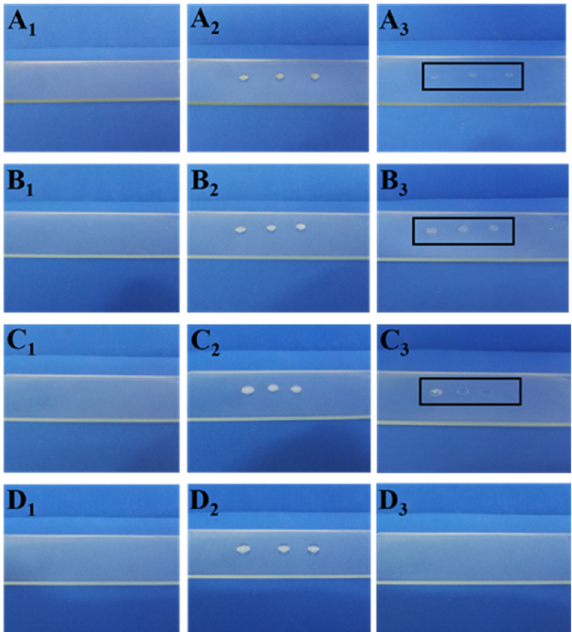
Figure 10. Coating water resistance test: images of P(CTFE- alt -IBVE)/MFWPU composite